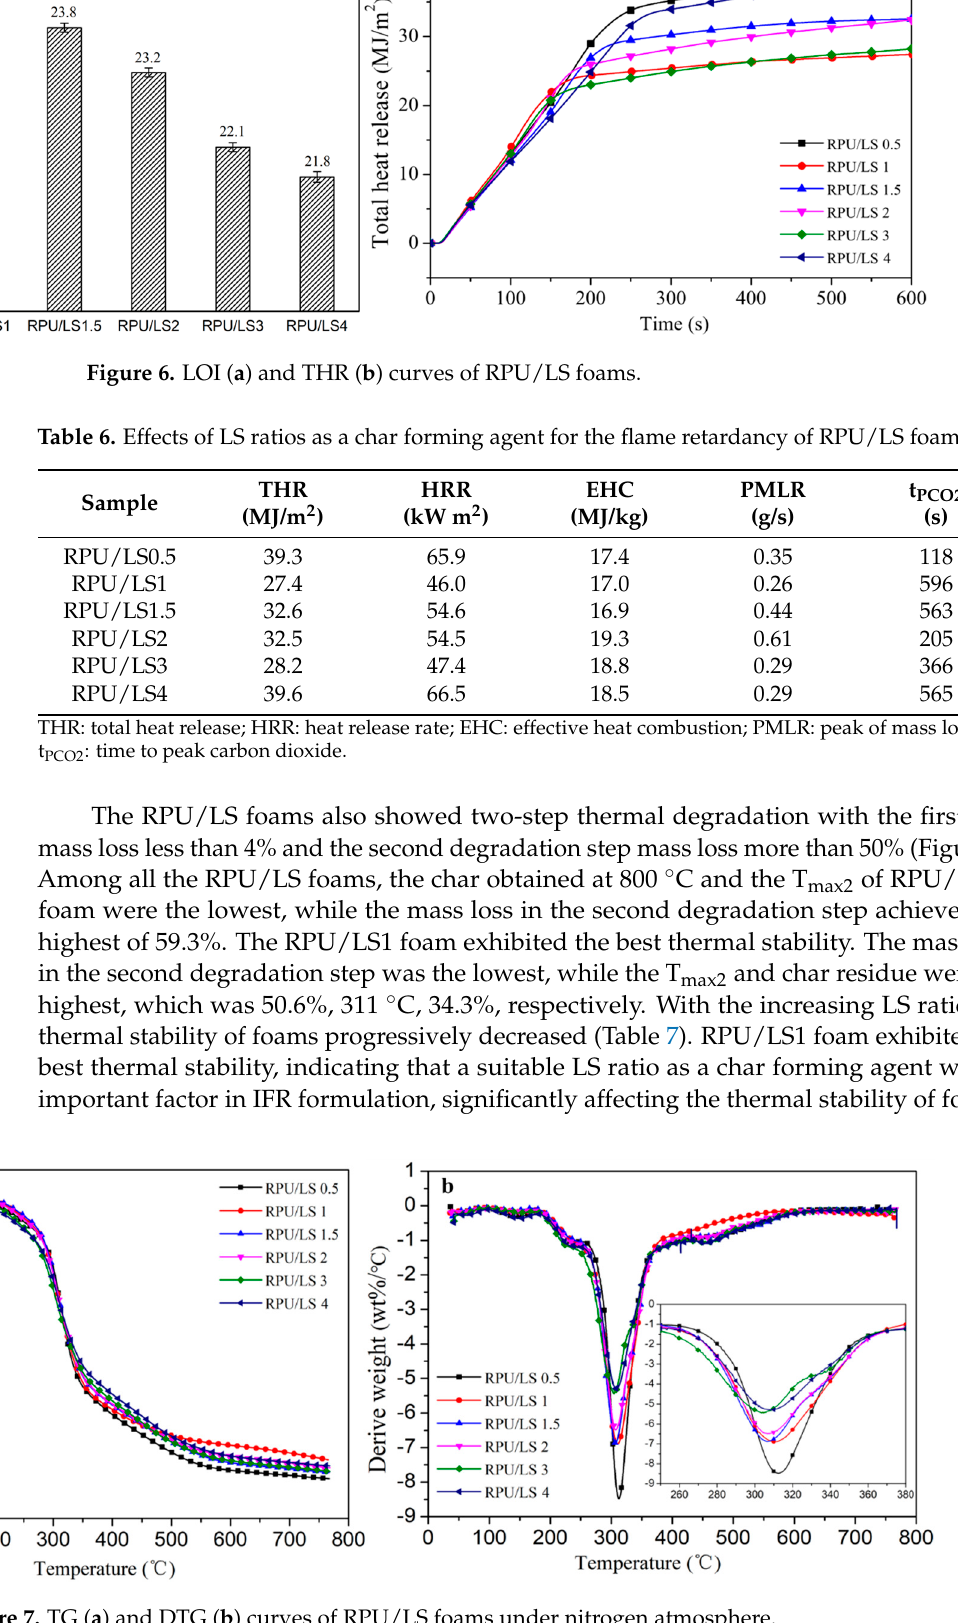
Figure 7. TG ( a ) and DTG ( b ) curves of RPU/LS foams under nitrogen atmosphere. Table 7. TG data of LS ratios as a char forming agent on the thermal stability of RPU/LS foams.